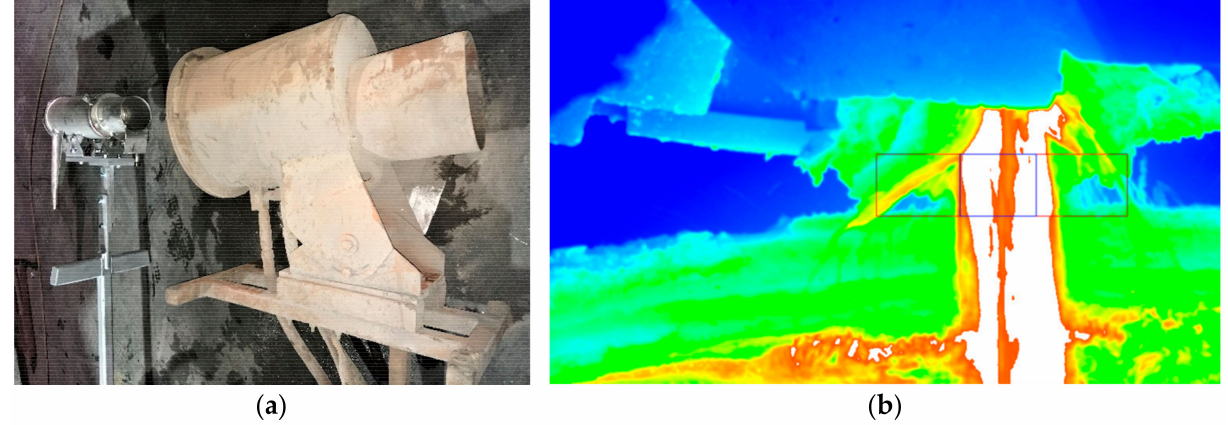
Figure 9. ( a ) Slag stopping systems with ( b ) infrared slag detection latest